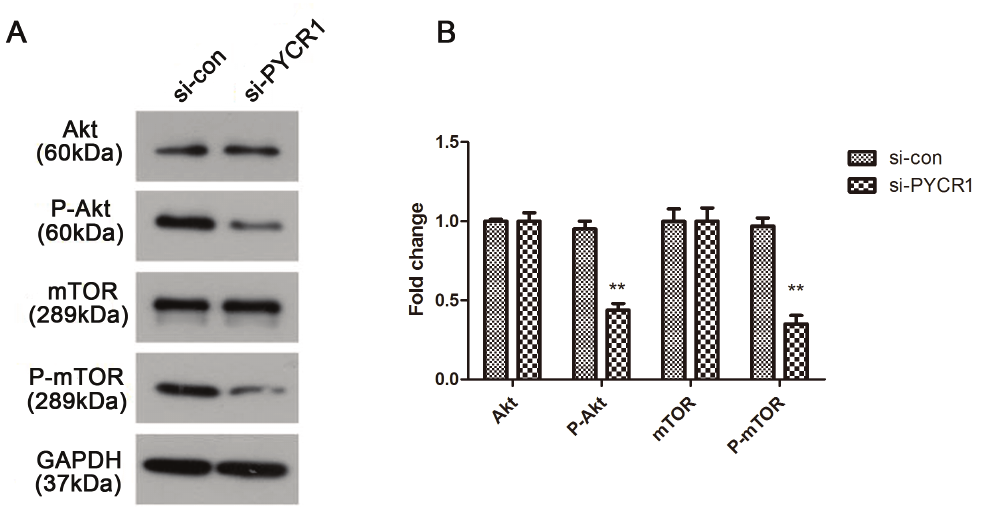
Figure 4: Silenced PYCR1 has a negative role on Akt/mTOR pathway in PRCC. (A) The expression level of Akt, p-Akt, mTOR and p-mTOR, with GAPDH considered as control. (B) Relative protein expression was quantified and depicted in column diagram. All the tests were carried out in triplicates independently. (**P <